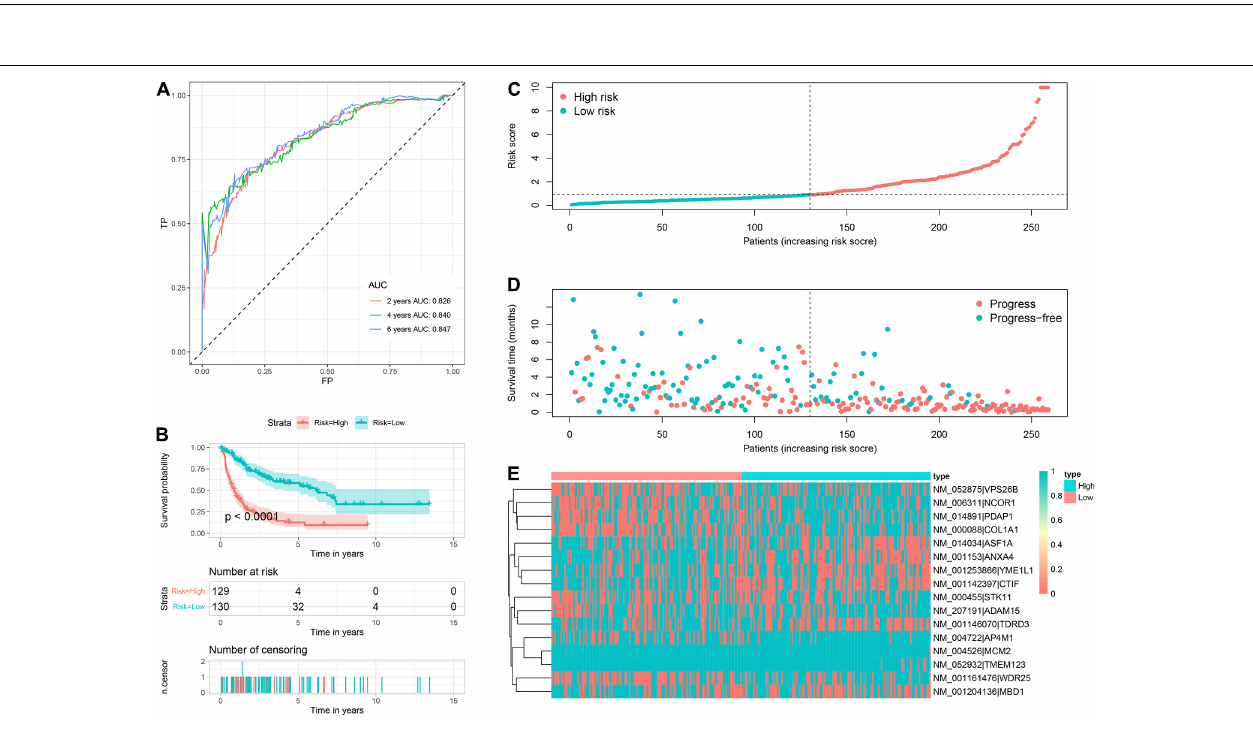
FIGURE 4 | Prognostic signature to predict PFS of sarcoma patients. (A) ROC curves of PFS signature. (B) Survival curve showed that high-risk patients were worse PFS than low-risk patients. (C) Risk score distribution of 259 sarcoma patients. (D) PFS status of 259 sarcoma patients. (E) Heatmap showed the distribution of PDUI of 16 PFS-related events in low- and high-risk patients. PFS, progress free-survival; ROC, receiver operating characteristic; APA, alternative polyadenylation.